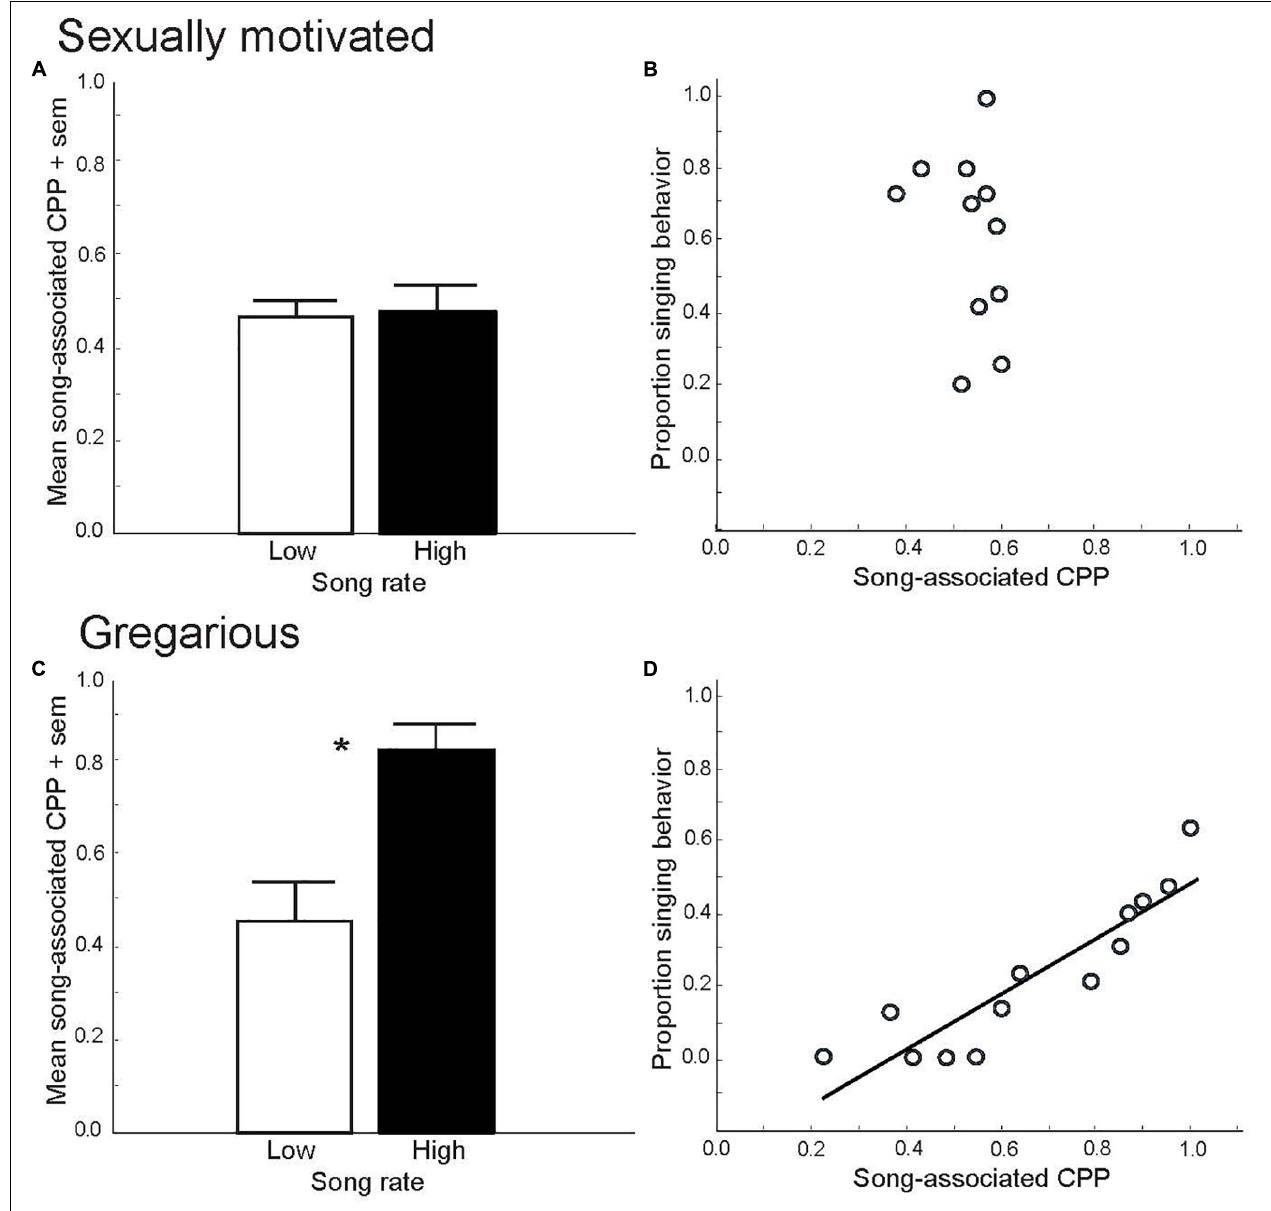
FIGURE 1 | Conditioned place preference (CPP) tests demonstrate that sexually motivated and gregarious singing behavior reflect distinct emotional states. Mean proportion time spent in a location (i.e., song-associated CPP) that had been paired previously with either low (open bar) or high (filled bar) rates of singing behavior in male starlings singing in response to a female in spring (A) and singing in a flock in fall, ∗ p = 0.006 (C) . Figures A and C replotted to show correlations between song and CPP in male starlings in spring, ns (B) and fall, p = 0.000002 (D) . Y -axis represents the proportion of all vocal behaviors that were songs produced by males during and just prior to being placed into a uniquely decorated place (i.e., a birdcage). The X -axis represents the proportion of time males later spent in that place the following day (CPP, considered a reflection of song-associated reward). Each point represents data from a single male. Figures redrawn from Riters and Stevenson